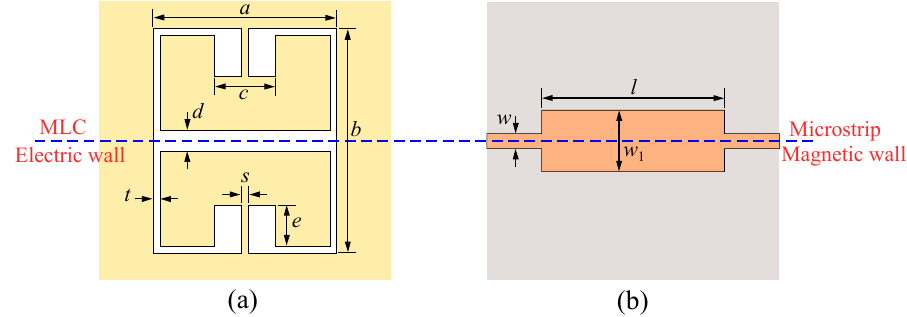
Figure 1. Layout of a microstrip transmission line loaded with a magnetic-LC resonator. ( a ) Bottom view and ( b ) top view. The microstrip metallization is shown in orange, the ground plane metallization in yellow, and the dielectric substrate is shown with gray color. The geommetrical dimensions are a = 10.2 mm, b = 15.4 mm, c = 2.6, d = 2.2 mm, e = 2.6 mm, s = t = 0.2 mm, w = 1.2 mm, and w 1 = 6.2 mm.